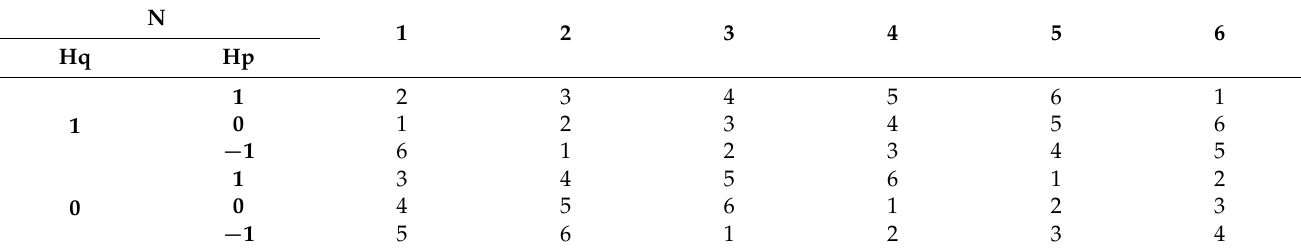
Table 2. Switching table for classical DPC